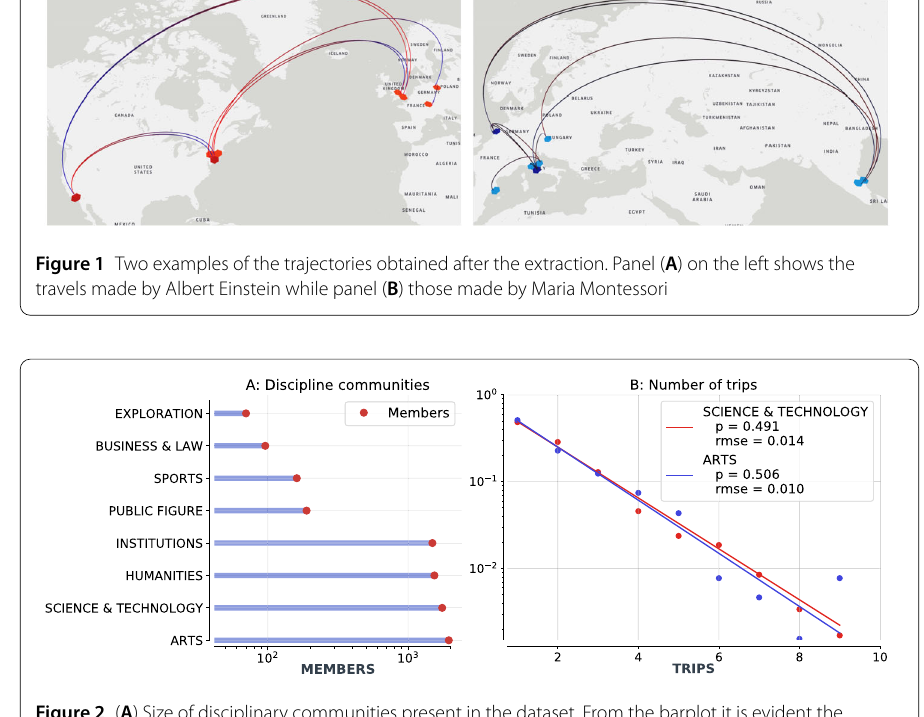
Figure 2 ( A ) Size of disciplinary communities present in the dataset. From the barplot it is evident the difference in the number of notable individuals between arts, science&technology, humanities, institutions and public figures, sports, business&law, exploration. ( B ) Distribution of the number of trajectories per person in the set of notable people. The lines represent the geometric fit to the distributions of the two most numerous disciplines, i.e. Arts and ScienceandTechnology . Both distributions can be described in terms of a geometric distribution with parameter p ∼ 1